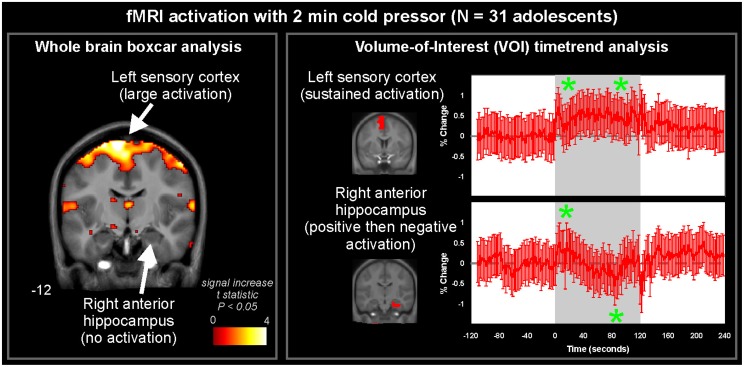
Whole-brain and volume-of-interest analysis of fMRI signal during 2 min cold pressor in 31 healthy adolescents (age 15.0 ± 2.5, 14 female/17 male). Left: A whole-brain analysis of activations fitting a pre-determined pattern (boxcar, as in Figure 1C) highlights the sensory cortex and adjacent areas (pseudo-colored areas of significance overlaid onto anatomical background), but not right hippocampus. Right: Timetrend analysis of VOI based on pre-determined regions derived from the Automated Anatomical Labeling atlas (Tzourio-Mazoyer et al., 2002), highlighting significant activations (indicated by *) in both the sensory cortex and right hippocampal area (repeated measures ANOVA, P < 0.05) (Data from Valladares et al., 2006).